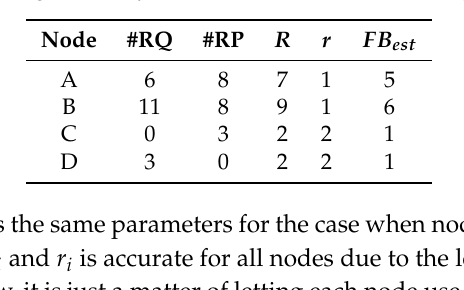
Table 2. Repeal-flooding boundary estimation from node D seeking a route to node C.